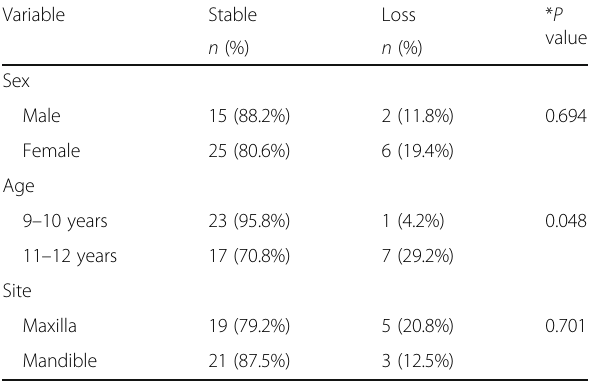
Table 5 Stability of the mini-implants, according to the sex, age, and installation site